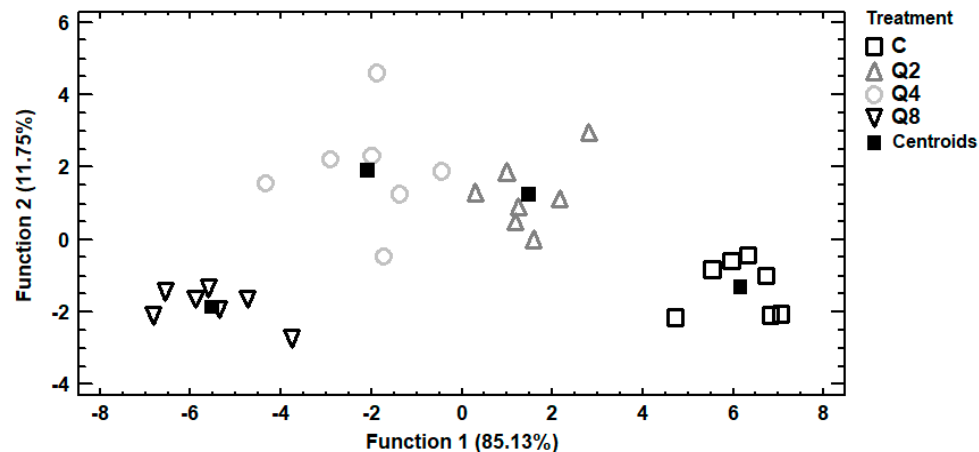
Figure 4. Discriminant plot separating egg shell samples, according to the dietary treatment, based on trace and macro elements.